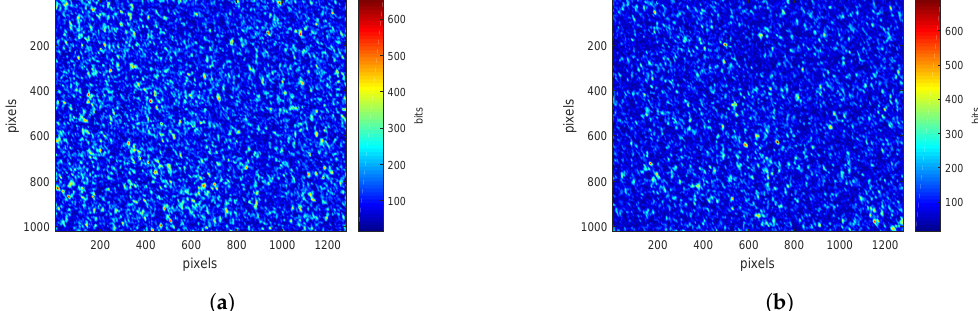
Figure 3. Speckle patterns at 785 nm for ( a ) pp- polarization ( b ) ps -polarization with a color scale defined by the minimum and maximum values of pixels.